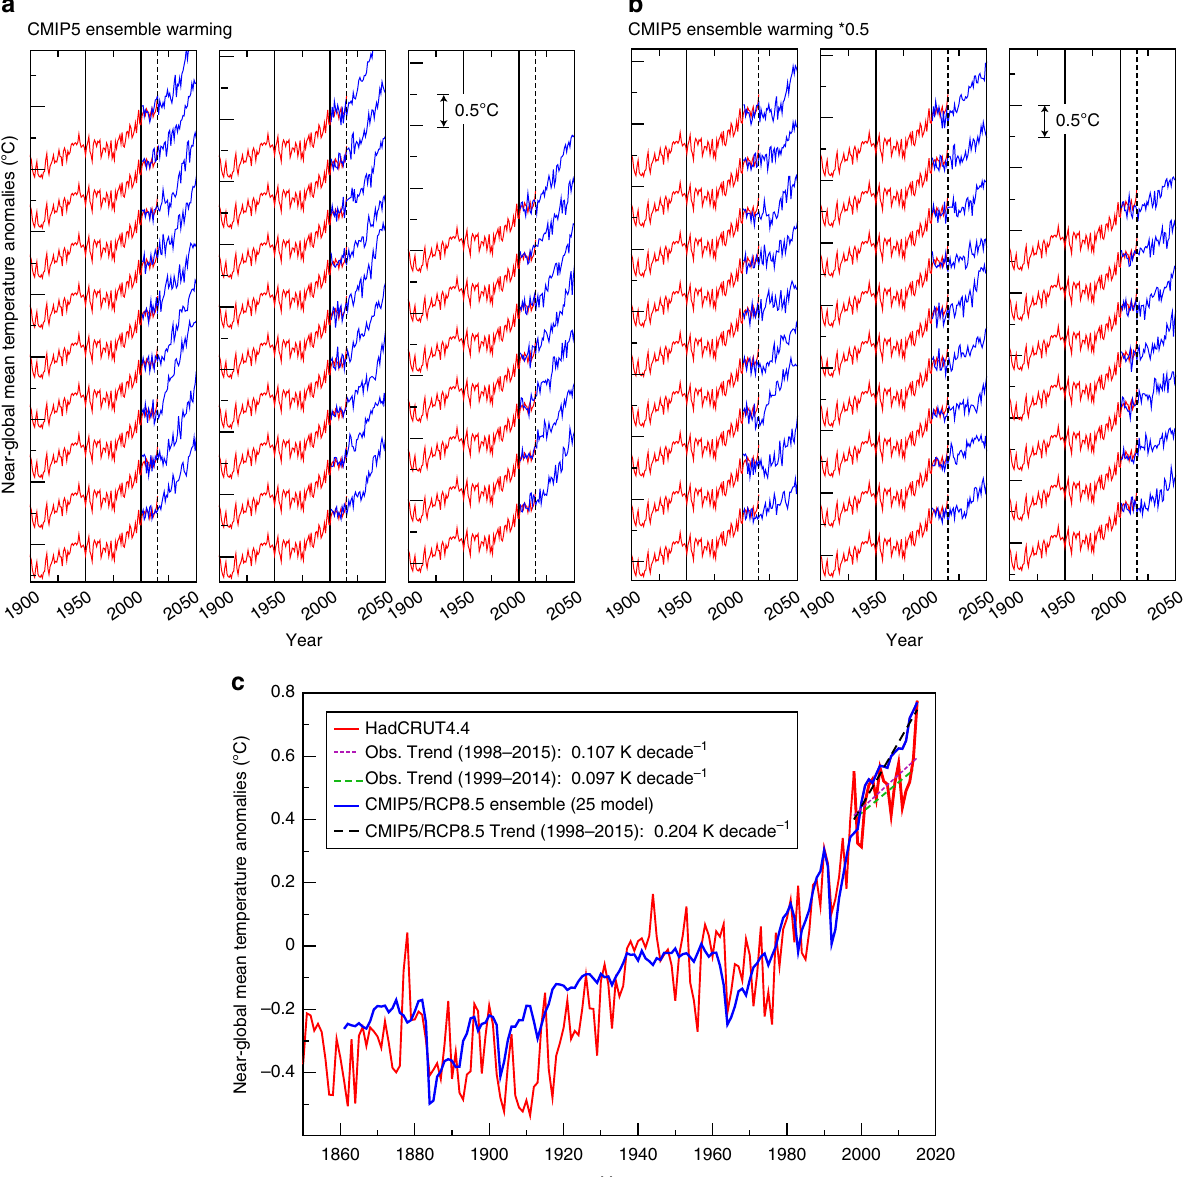
Figure 5 | Historical global mean temperature timeseries from models and observations along with future model projections. ( a ) Synthetic near-global (60 (cid:2) S-80 (cid:2) N) annual time series combining historical observations from HadCRUT4.4 (red) with several projections from climate models (blue). Each of the 25 projections in a , b combines the CMIP5 multi-model RCP8.5 warming projection with a different episode of multidecadal internal variability cooling from the CM3 control run. Series are plotted with an arbitrary vertical offset for display purposes (see 0.5 (cid:2) C scale indicator; tic marks on vertical axis are at 0.5 (cid:2) C intervals). The dotted vertical lines denote the year 2015 for reference. The synthetic series are constructed using the observed mean anomaly for 1996–2005 as the reference value. Each model projection begins in 2001, using the first year of the CM3 control run segment combined with a long-term warming projection of near-global surface air temperature. The warming projection contribution is adjusted to have zero magnitude in year 2000. The CM3 anomalies, averaged over years 1–10 of the selected segment, are also adjusted to have the observed reference value. ( b ) As in a but the long-term warming projection contribution is adjusted by the factor 0.5 to explore effects of a smaller transient climate sensitivity than that simulated in the CMIP5 multi- model ensemble. ( c ) Observed (HadCRUT4.4; red) and CMIP5 multi-model ensemble (All-Forcing/RCP8.5; n ¼ 25) simulated (blue) near global temperature anomalies (80 N-60 S, using modelled SST over ocean regions and 2-metre air temperature over land. Model data masked with observed missing data mask. Anomalies are relative to 1961–1990. HadCRUT4.4 observed (purple dashed: 1998–2015; or green dashed: 1999–2014) and CMIP5 modelled (black dashed: 1998–2015) trends are compared over recent periods (see